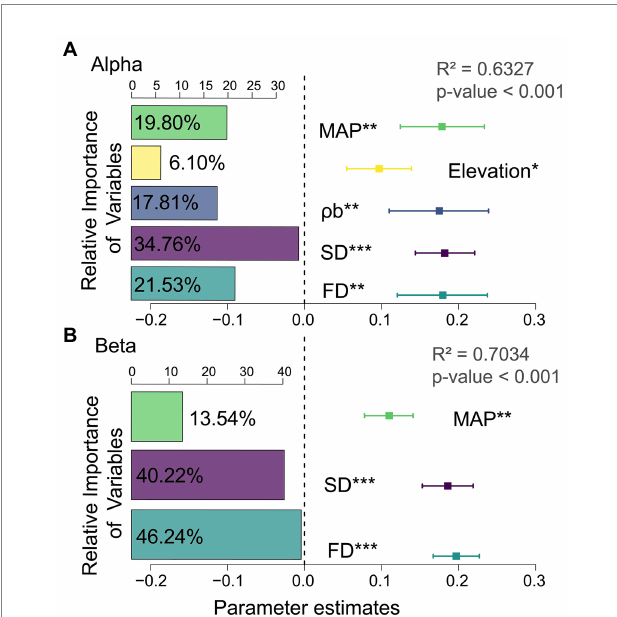
FIGURE 1 Standardized regression coefficients and associated 95% confidence intervals for the multifunctional model predictor variables. The left insets are relative importance of variables explained by the model. The right insets represent the standardized regression coefficients. See Supplementary Table S5 for the standardized regression coefficients for each predictor variable. (A) alpha diversity; (B) beta diversity; MAP, mean annual precipitation; ρ b, soil bulk density; SD, species diversity; FD, functional